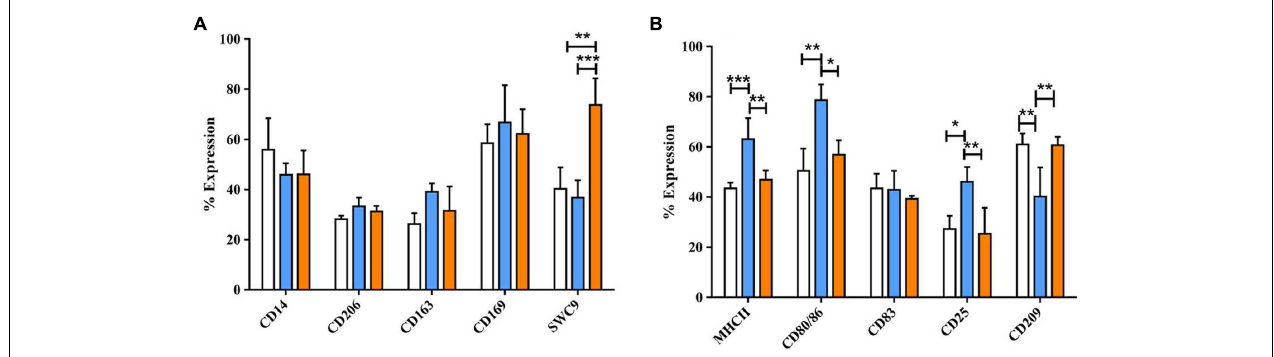
FIGURE 1 | Phenotypical analysis of porcine M1 and M2 MoMØs. Freshly isolated peripheral porcine monocytes were treated with M-CSF for 4 days to obtain MoMØs. MoMØs were treated with IFN- γ and LPS to generate M1 macrophages (blue) or with IL-4 to generate M2 macrophages (orange), or MoMØs were left unstimulated (unfilled bars). After a further 24 h MoMØ were harvested and stained with various antibodies to assess their surface expression of pathogen recognition receptor/lineage markers (A) or antigen presentation/co-stimulatory molecules (B) for flow cytometry analysis. Data represent mean percentage of cells expressing markers + SD. One-way ANOVA was used to assess significance followed by Bonferroni’s multiple comparison test ∗∗∗ p < 0.0001, ∗∗ p < 0.001, ∗ p < 0.05.